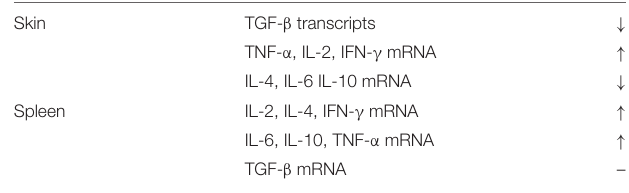
TABLE 2 | Association of the affinity magnitude of anti-topo I reactive CD27 + B cells with cytokine production profile.